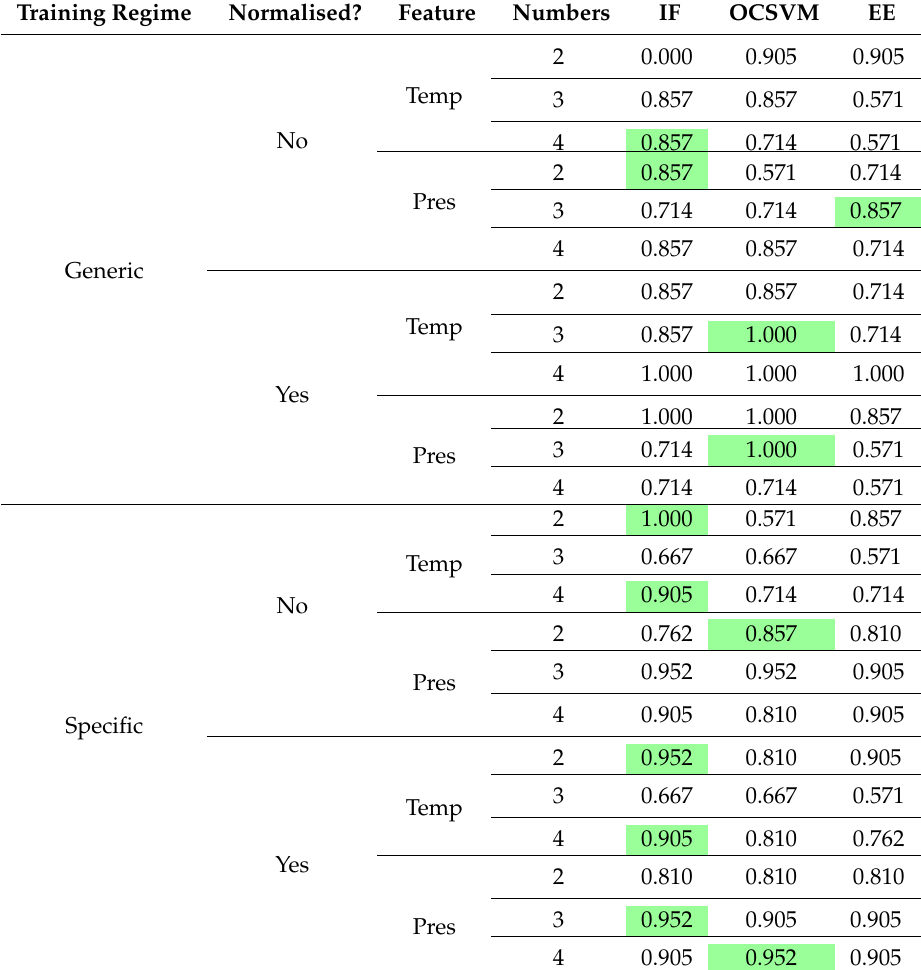
Table 4. Table of accuracies for the various tests conducted in this paper. Values in green are when that model performed better than the